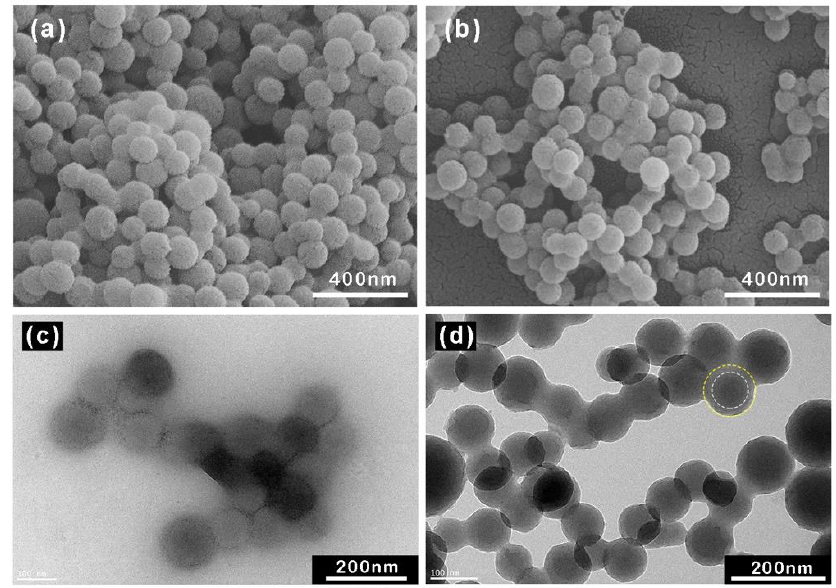
Figure 2. Field emission scanning electron microscopy (FESEM) images of ( a ) carbon spheres (CS) and ( b ) ASPB. Transmission electron microscopy (TEM) images of ( c ) CS and ( d ) ASPB.